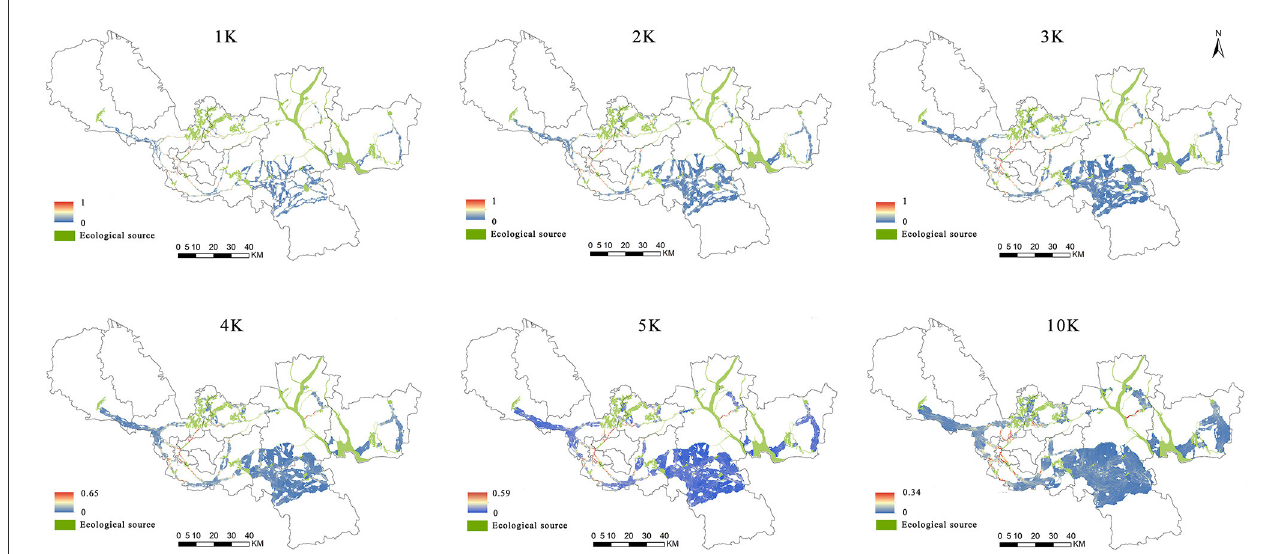
FIGURE8 Ecological corridor extent and cumulative proportion at different thresholds (K for thousands and the number in each image represents the distance threshold for corridor